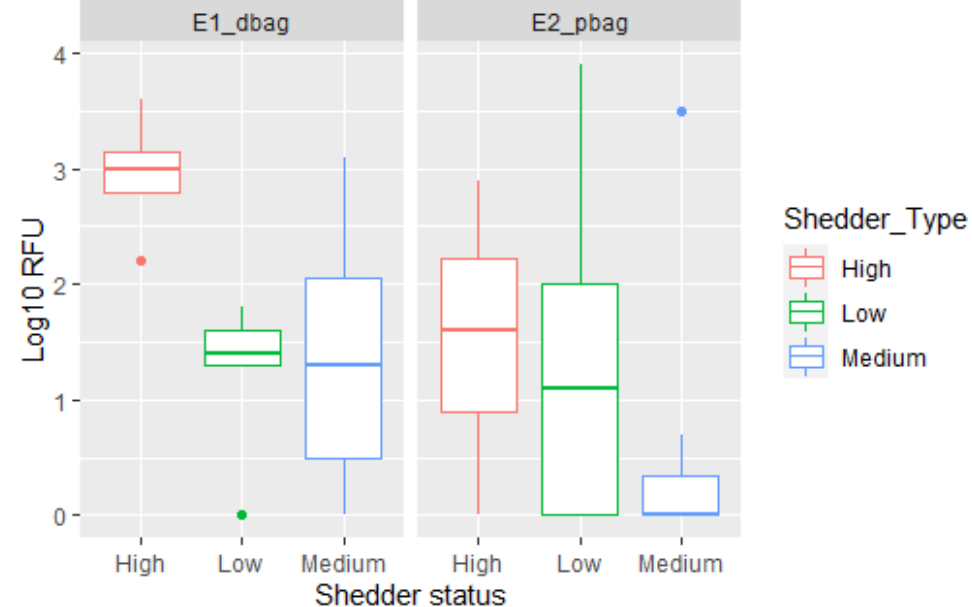
Figure 5. Boxplot displaying the log10 RFU detected in the direct transfer experiment ( E 1 dbag ) and indirect transfer from personal bag ( E 2 pbag ) according to the participants’ shedder classification. Data from persistence and detection of DNA from a previous user of a tape roll experiment showed that low shedders only provided low quality profiles and that higher quality profiles were provided by high shedders. Medium shedders provided both high and low quality results. (Figure